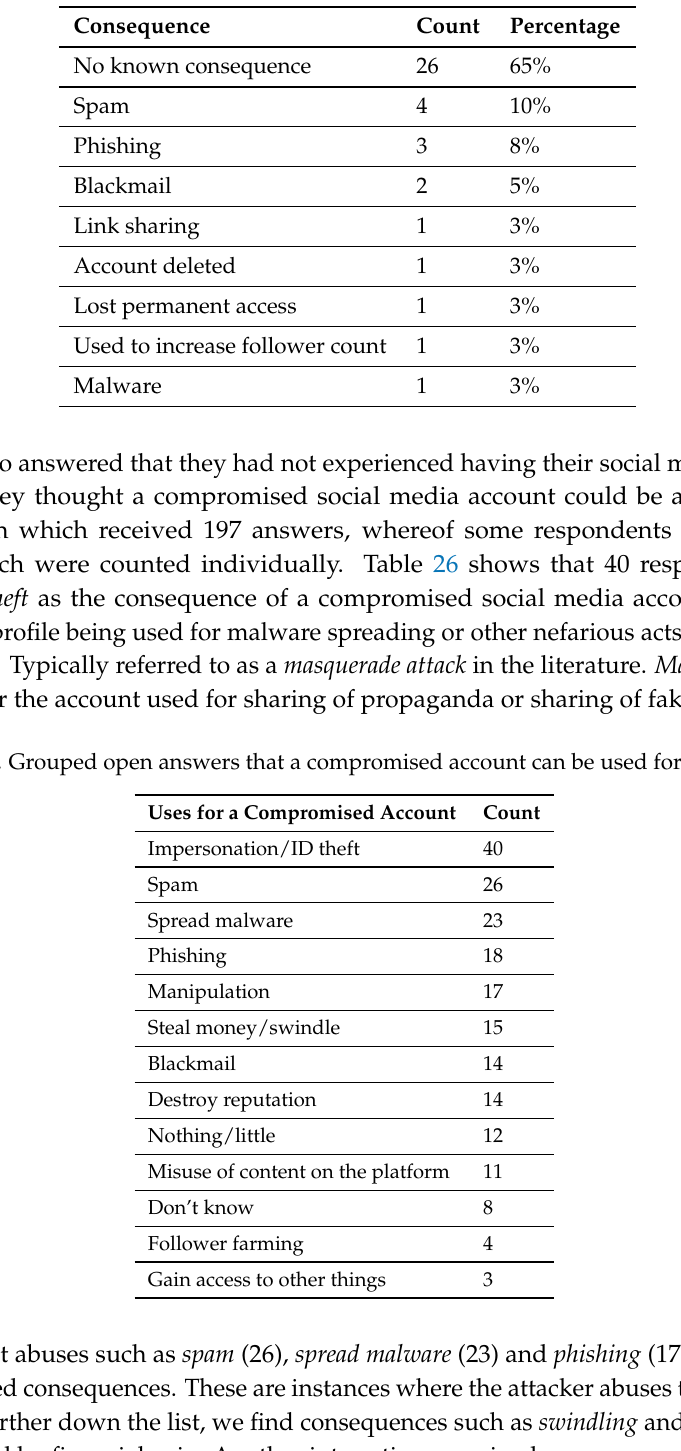
Table 25. Shows categorized reasons for compromise from text answer in the questionnaire. The reasons have been grouped a bit together with other similar consequences N = 40.